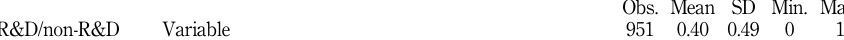
Table IV. Summary